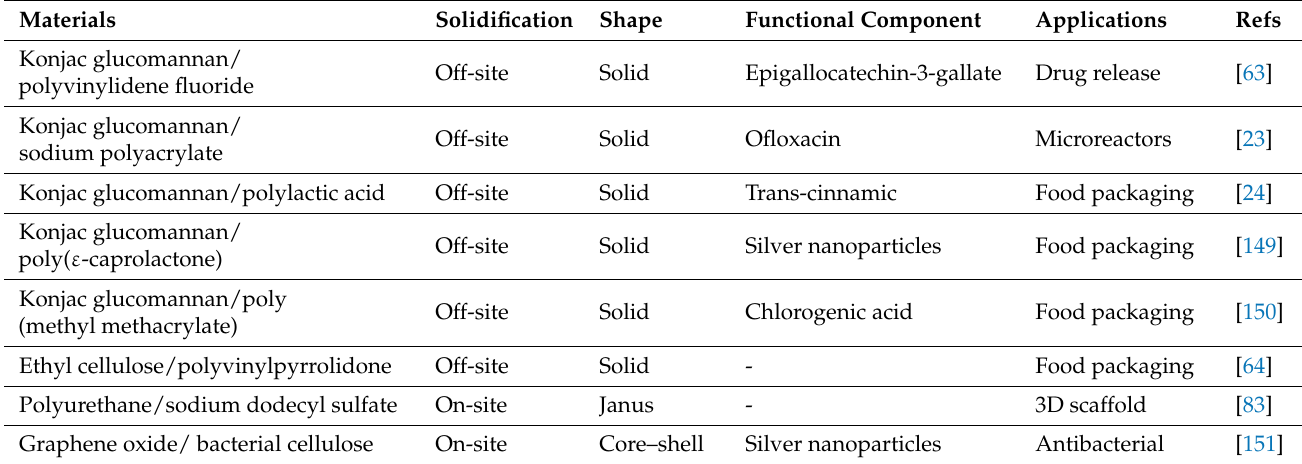
Table 3. Summary of the applications of micro-/nanofibers and films in food processing and